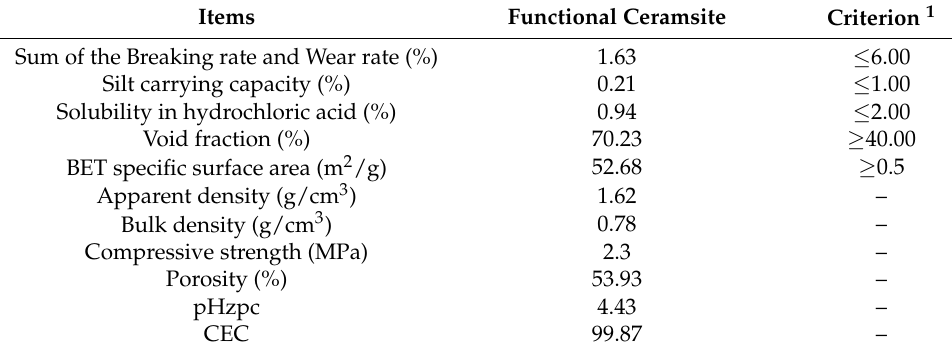
Table 2. The physical characteristics of functional